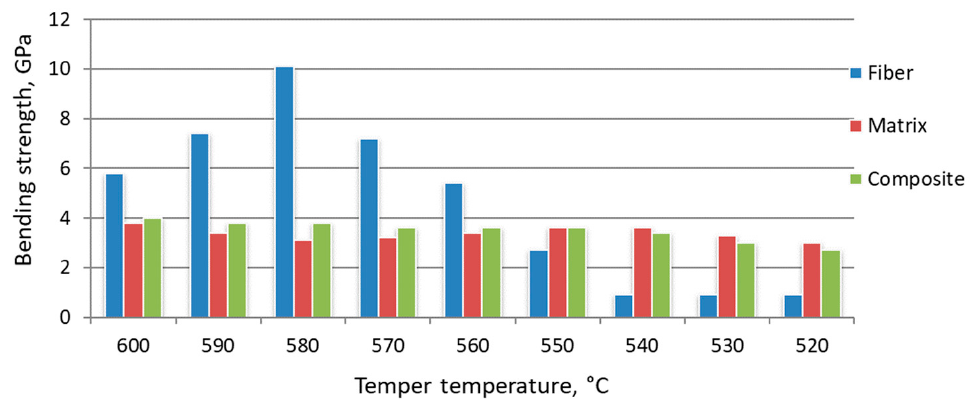
Figure 18. Effect of tempering temperature on the characteristics of composite material based on W6Mo5Cr4V2 steel, hardened at 1290 °C.